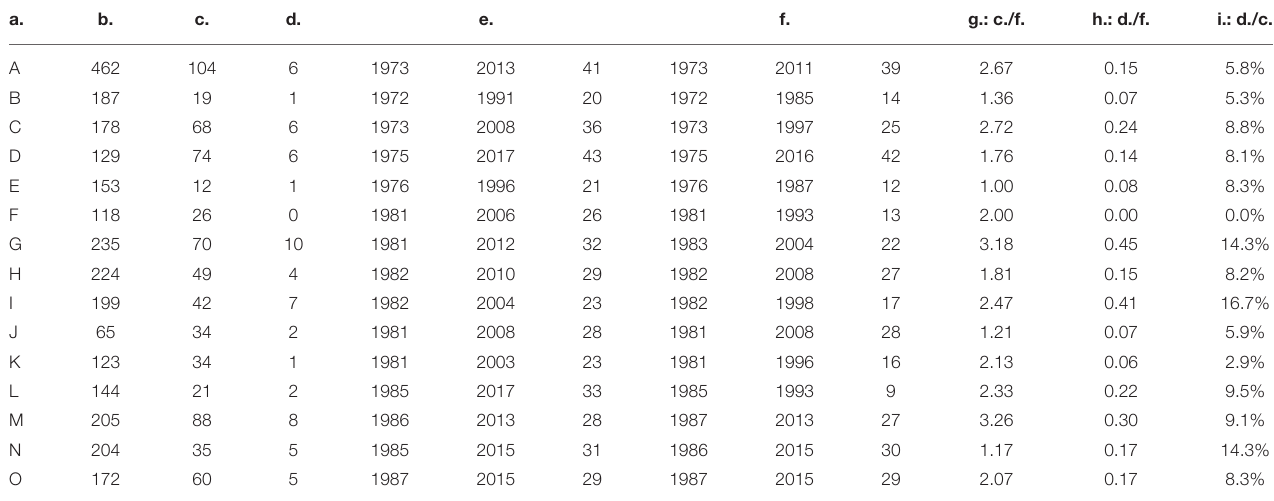
TABLE 5 | Patent productivity of selected star researchers in the R&D department of a company: a. Researcher, b. Total number of patents, c. Number of patents filed as a primary inventor, d. Number of highly cited patents * filed as a primary inventor, e. Period of filing patents (first patent, last patent, period of filing patent/years), f. Period